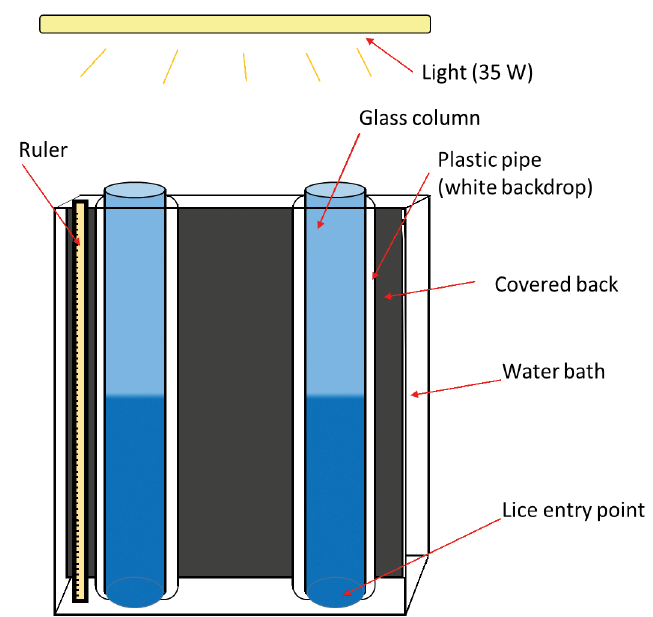
Fig. 1. Experimental column used to test the vertical distri- bution of nauplii and copepodid larvae of salmon lice in salinity